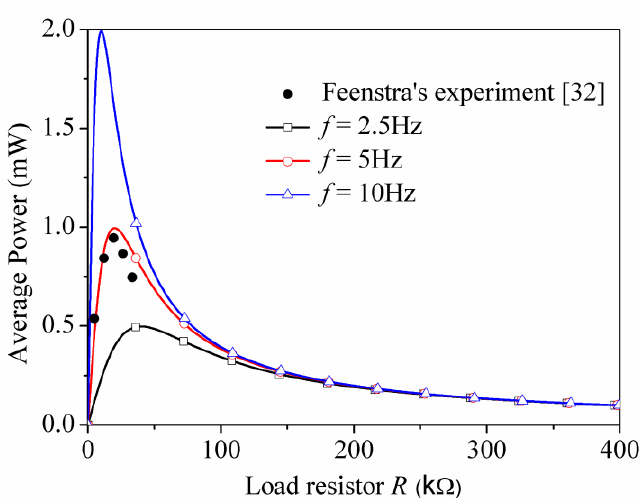
Figure 9. The average power changes with the load resistor.